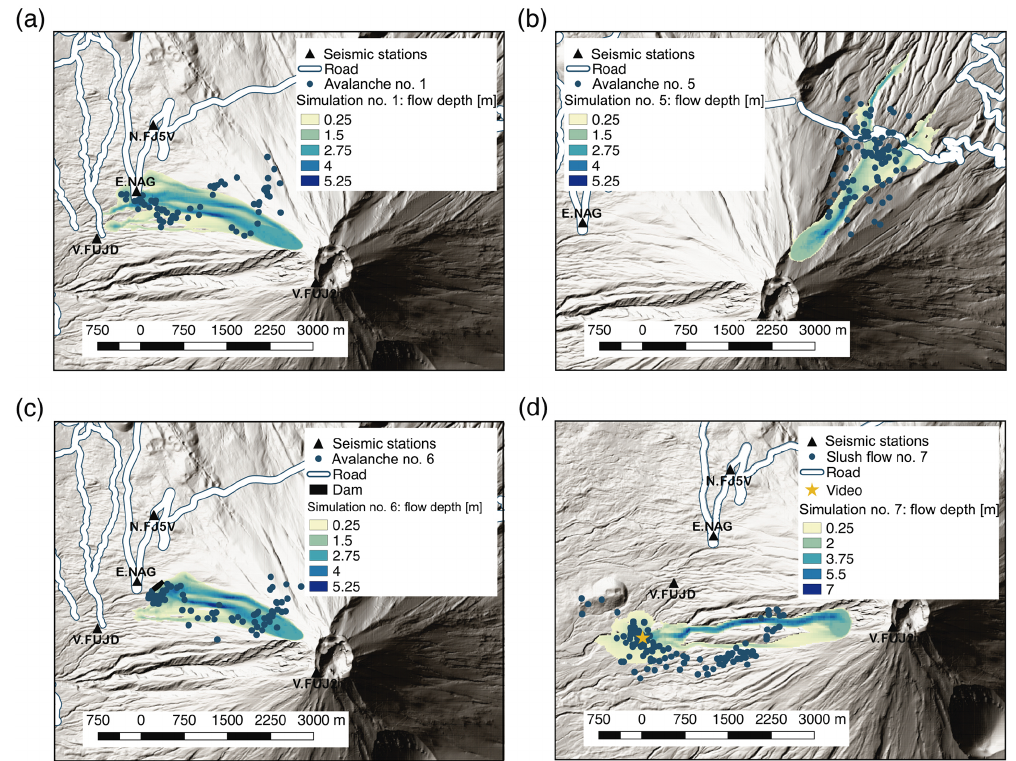
Figure 9. Flow depths simulated with Titan2D and estimated flow locations (blue points) from the seismic analysis of (a) avalanche #1,